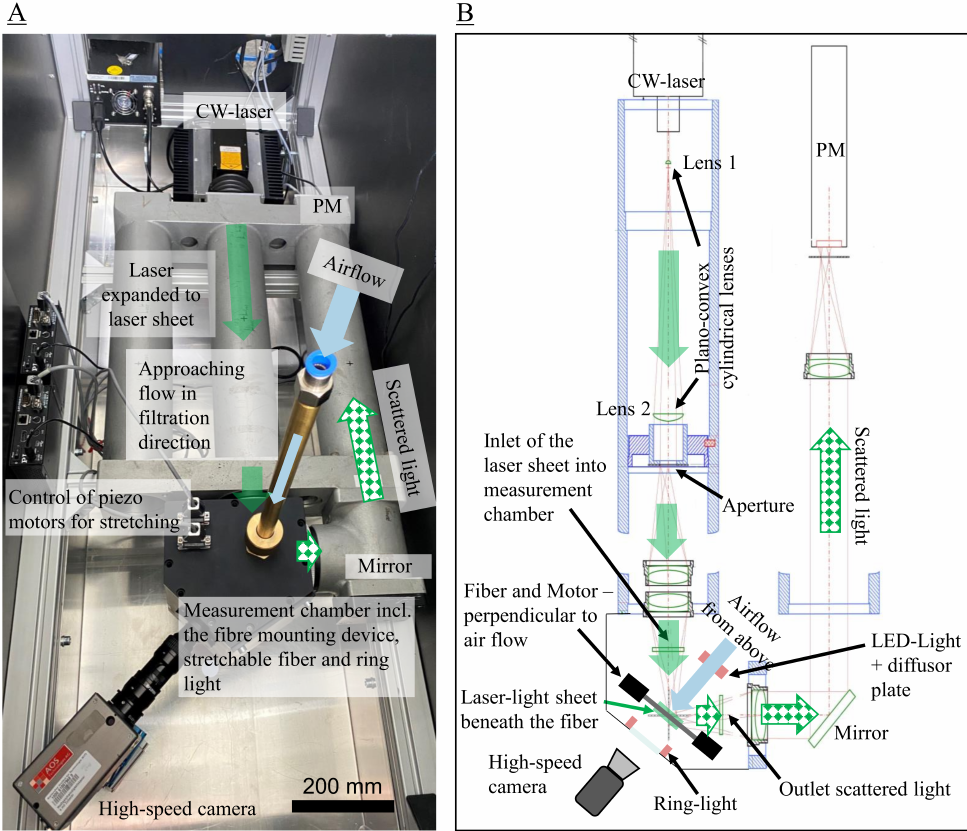
Figure 5. Image ( A ) and schematic diagram ( B ) of the laser-light sheet measurement system. An expanded laser beam (thin sheet) runs below the fiber (shown in Figure 6B). The scattered light within the measurement area is captured focused onto a PM and transferred into electrical